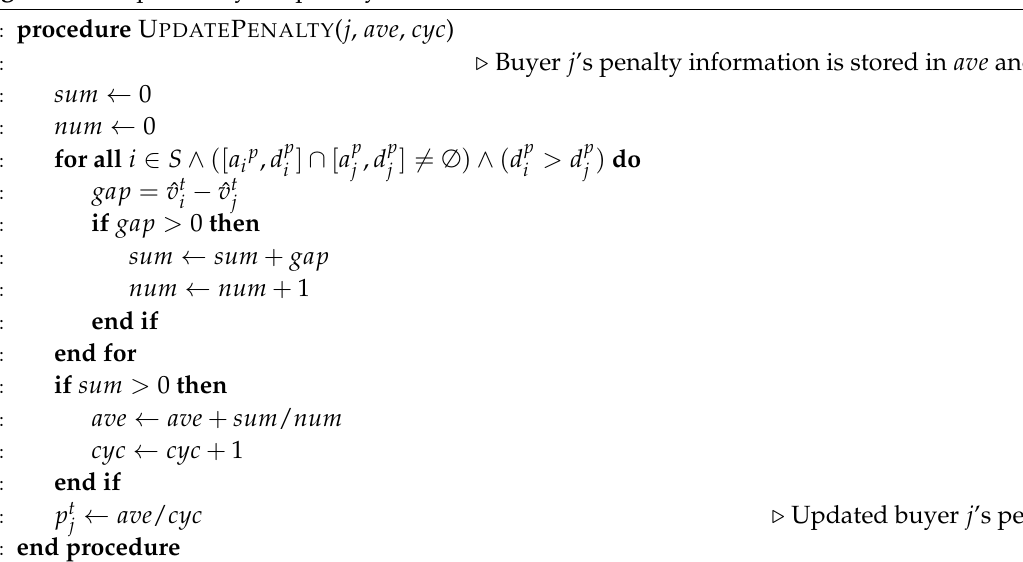
Algorithm 1 Update buyer’s